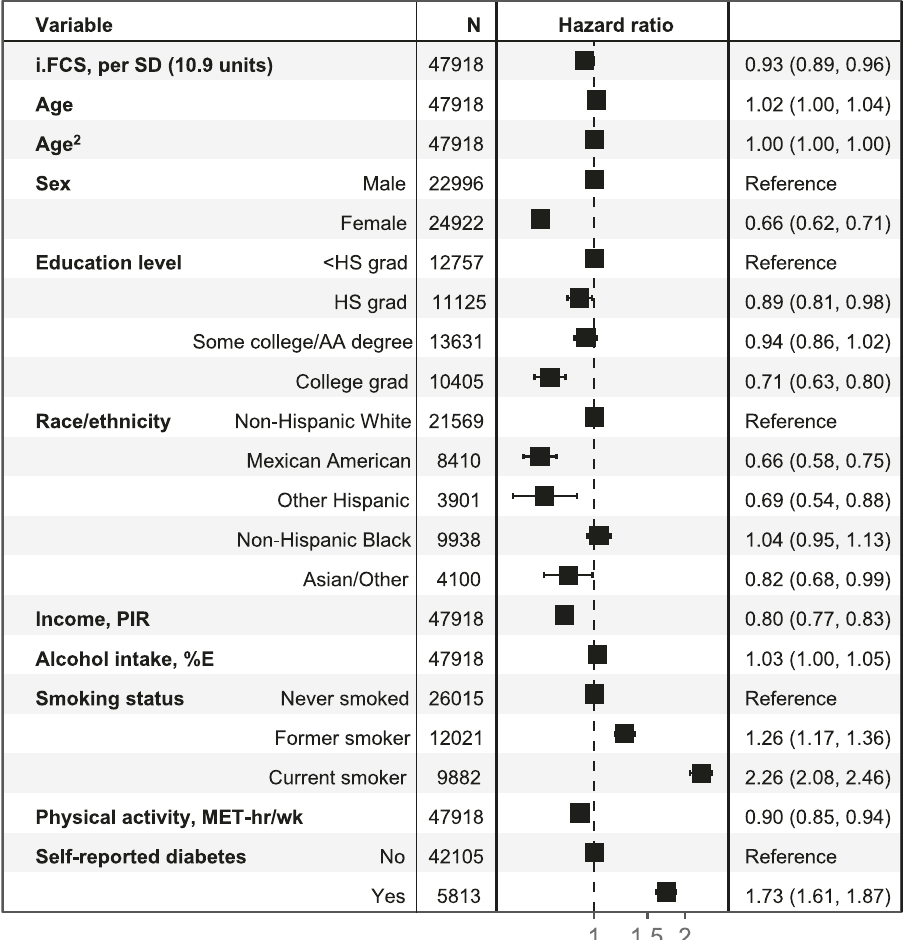
dietary recall sample weights to account for the complex survey design and response rates and provide nationally representative estimates for the non- institutionalized U.S.population.Allvariablesinthe Figurewereincluded together in the multivariable model. AA Associates Degree, grad graduate, HS high